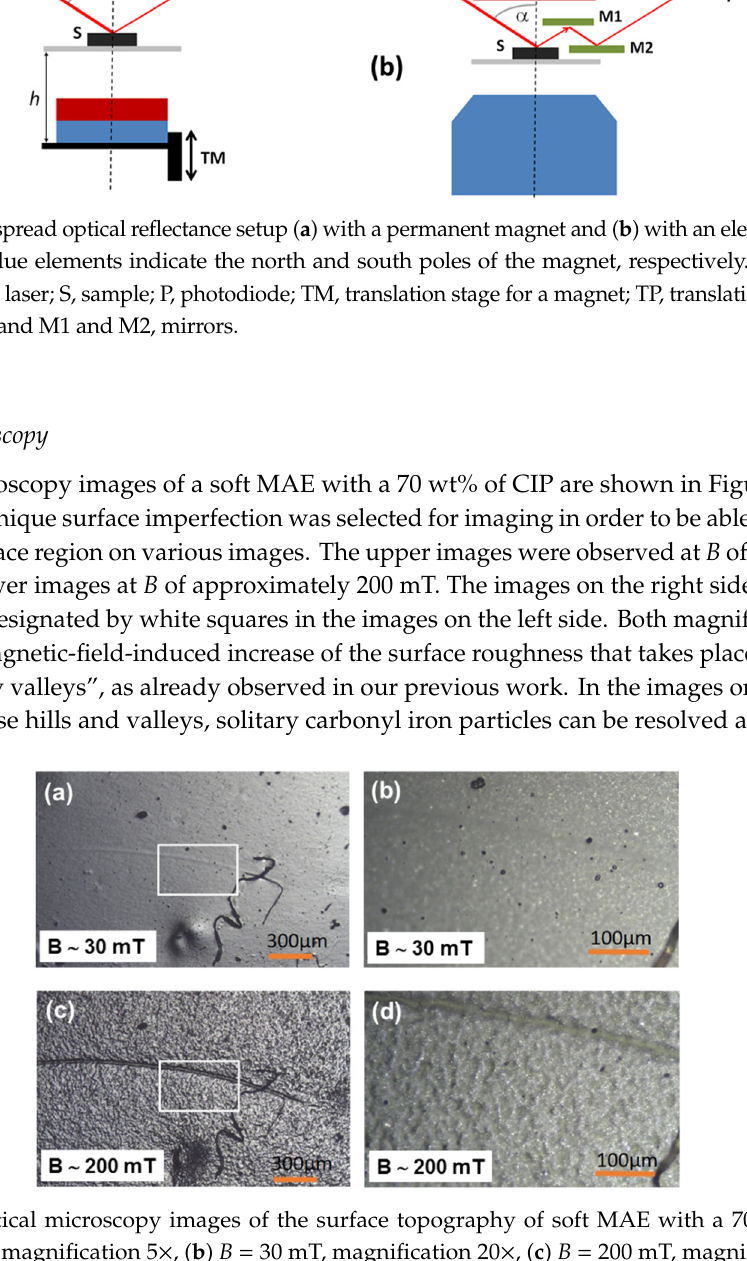
Figure 2. Optical microscopy images of the surface topography of soft MAE with a 70 wt% CIP: ( a ) B = 30 mT, magnification 5×, ( b ) B = 30 mT, magnification 20×, ( c ) B = 200 mT, magnification 5×, and ( d ) B = 200 mT, magnification 20×.